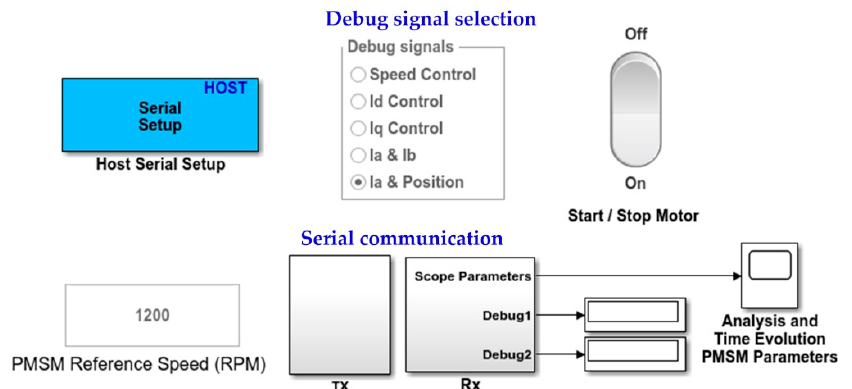
Figure 35. MATLAB/Simulink software interface for the monitoring and control application on the Host PC.